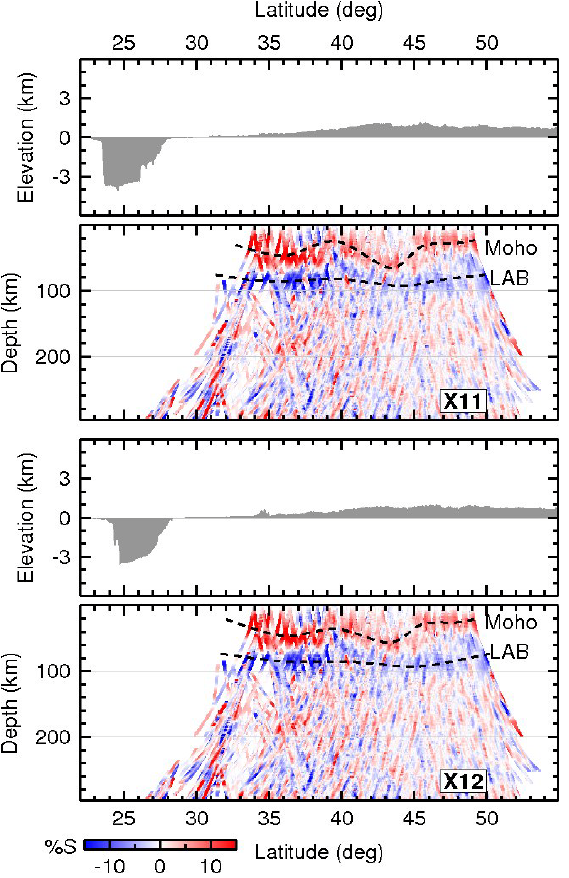
Fig. 19. Migrated S receiver functions along profiles X13 and X14 Fig. 18. Migrated S receiver functions along profiles X11 and X12 as in Fig. as in Fig. 3. Migrated S receiver functions along profiles X13 and X14 as in Fig. 3.